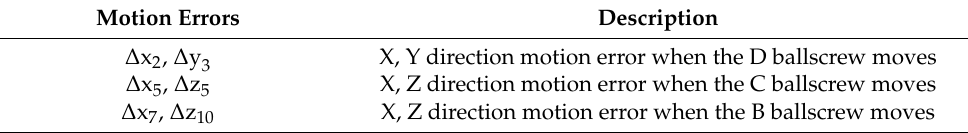
Table 2. Motion error parameters of platform due to ballscrew nut movement.